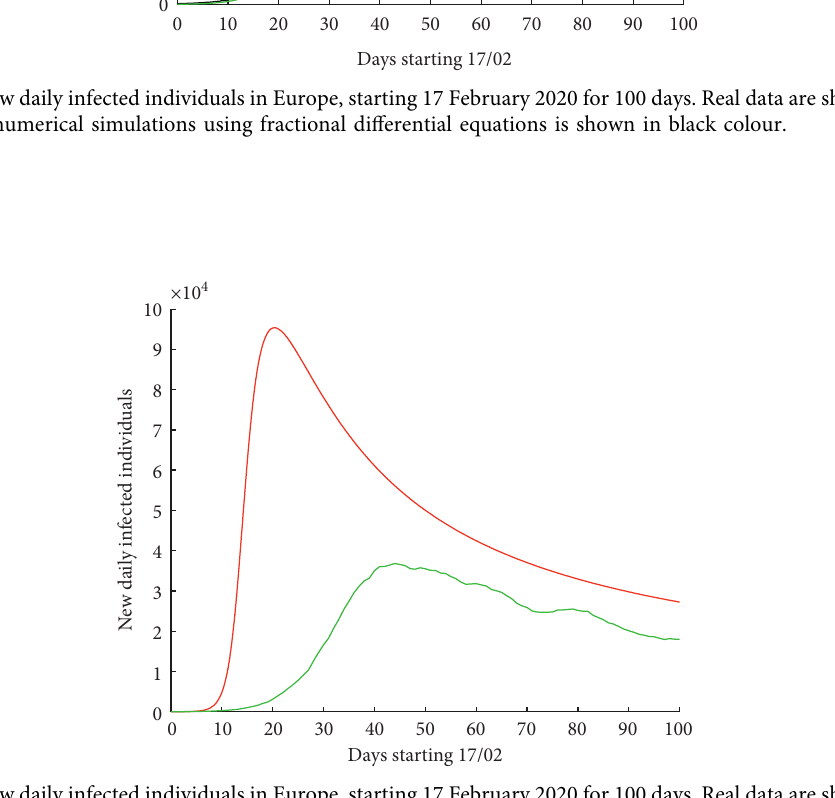
Figure 6: Number of new daily infected individuals in Europe, starting 17 February 2020 for 100 days. Real data are shown in green colour, while the result of the numerical simulations of the hypothetic curve with 70% more of infectivity is shown in red